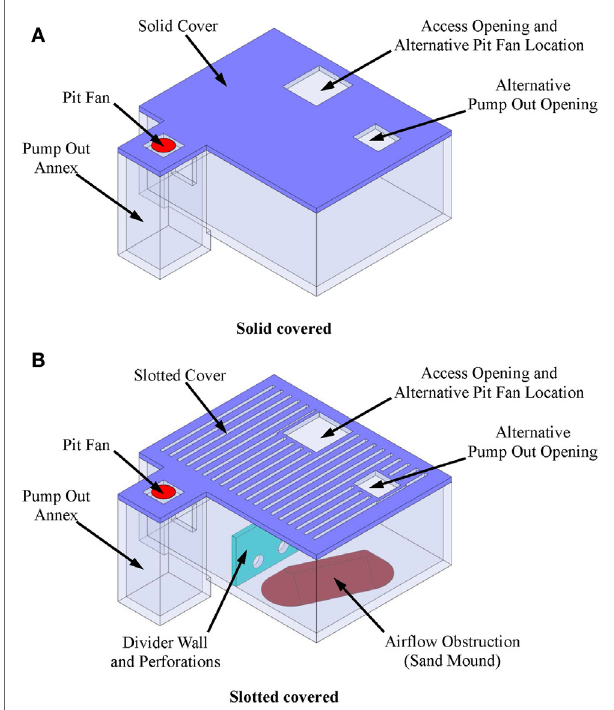
FIgURe 1 | Definition sketch of stand-alone manure pits with (A) solid cover and (B) slotted cover illustrating online tool additional features